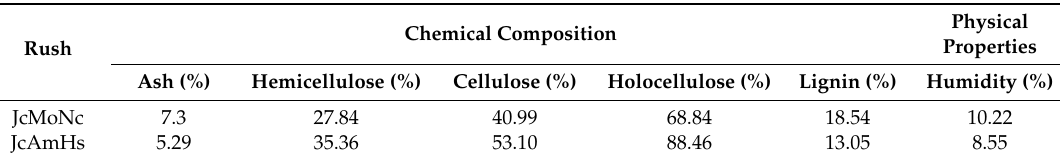
Table 1. Chemical composition and physical of rush stems derived from Tunisian regions [24].